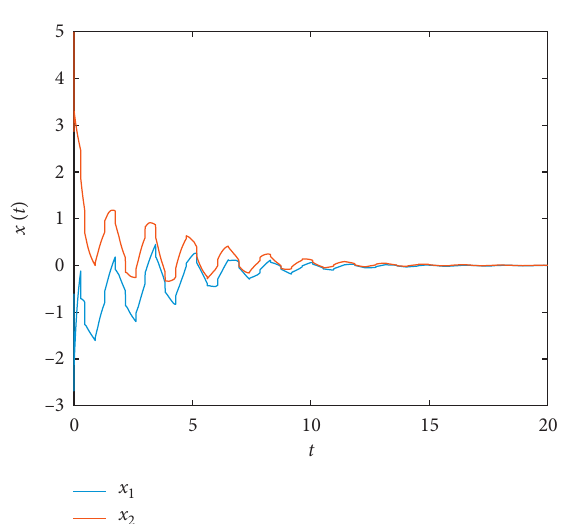
Figure 6: Responses of x